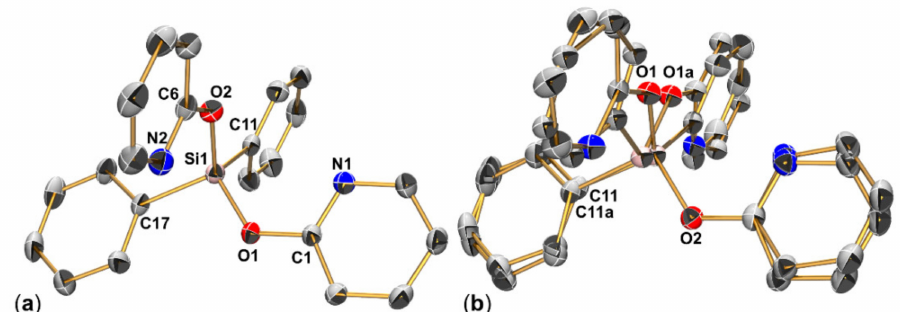
Figure 9. ( a ) Molecular structure of one of the three independent (but conformationally very similar) molecules of the asymmetric unit of 3a (thermal displacement ellipsoids are drawn at the 30% probability level, selected atoms are labeled, H atoms and disorder parts are omitted for clarity). ( b ) The disorder encountered in this structure corresponds to a site mismatch of one set of Ph and pyO groups. The same disorder motif is encountered with the other two molecules in the asymmetric unit as well. The site occupancies of disorder parts 1 and 2 are 0.930(2):0.070(2) for molecule 1 (the one shown in this graphic) and 0.881(2):0.119(2) for the related disorders in the remaining two